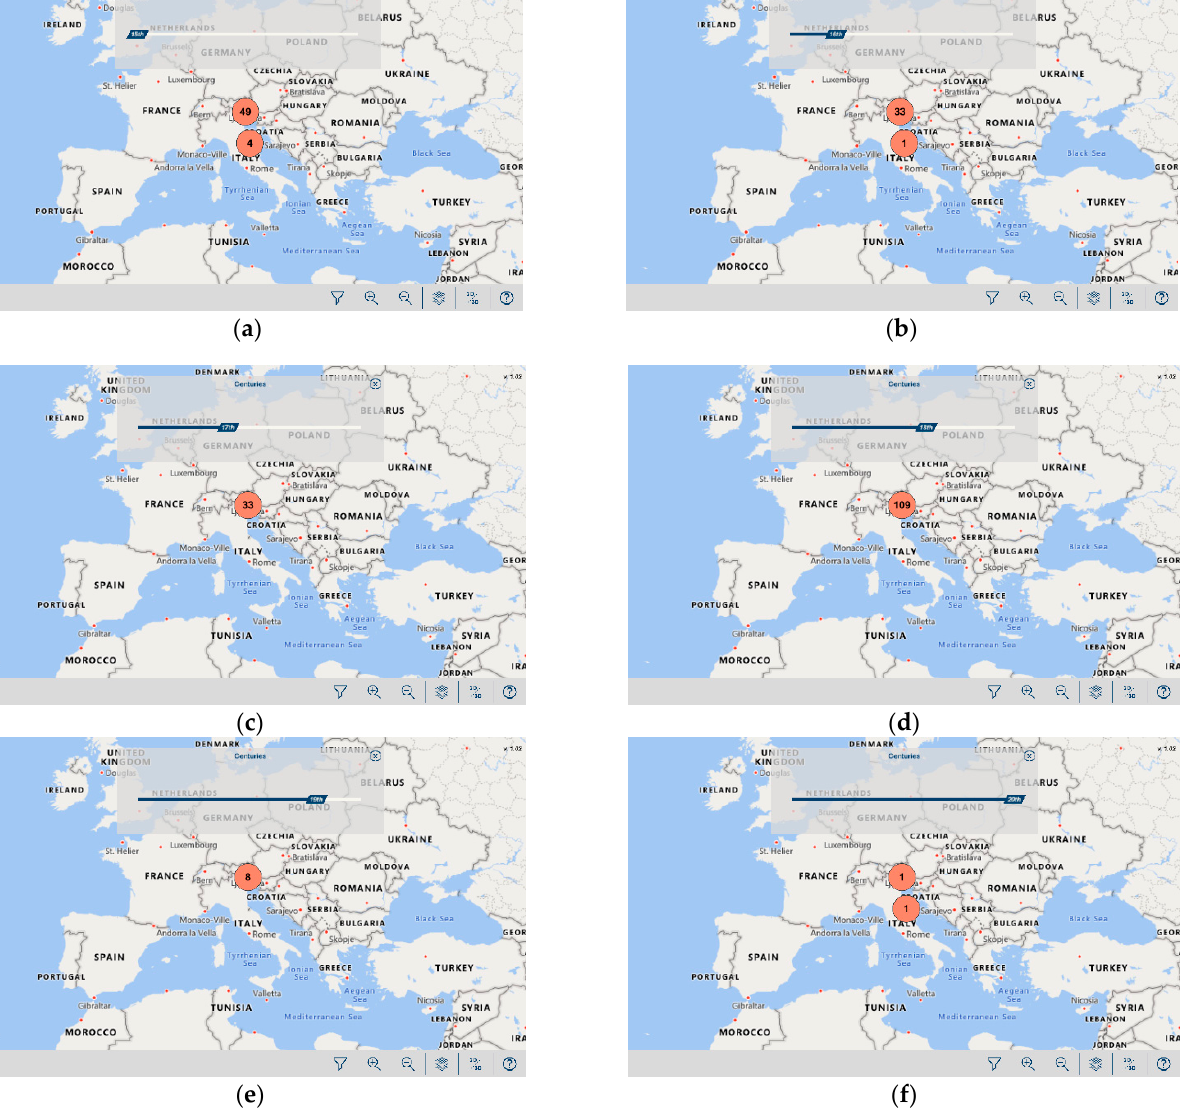
Figure 12. Temporal evolution of objects related to velvet, for the region of Venice, for the 15th to 20th centuries. ( a ) 15th century; ( b ) 16th century; ( c ) 17th century; ( d ) 18th century; ( e ) 19th century; ( f ) 20th century.